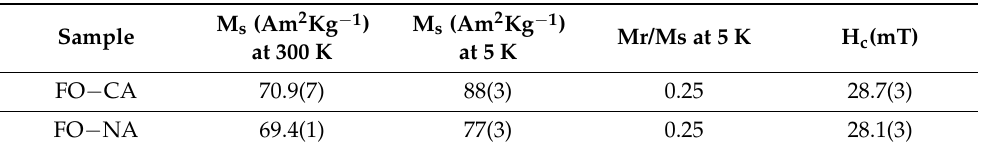
Table 4. Saturation magnetization (Ms) at 5 K and 300 K, reduced remanence magnetization (Mr/Ms) and coercive field (Hc) for FO − CA and FO − NA samples, uncertainties on the last digit are given in parentheses.